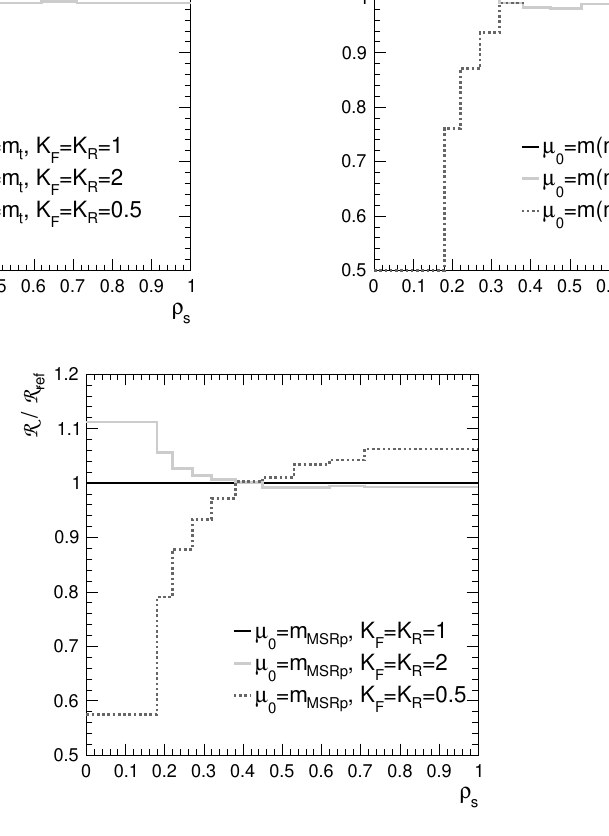
Figure 35 . Ratios of R distributions using different scale choices, i.e. µ R = K R µ 0 , µ F = K F µ 0 with µ 0 = m and K F = K R = 0 . 5 , 1, 2. Different panels refer to different renormalization schemes for the top-quark mass, i.e. the pole scheme (upper left), the MS scheme (upper right) and the MSR one